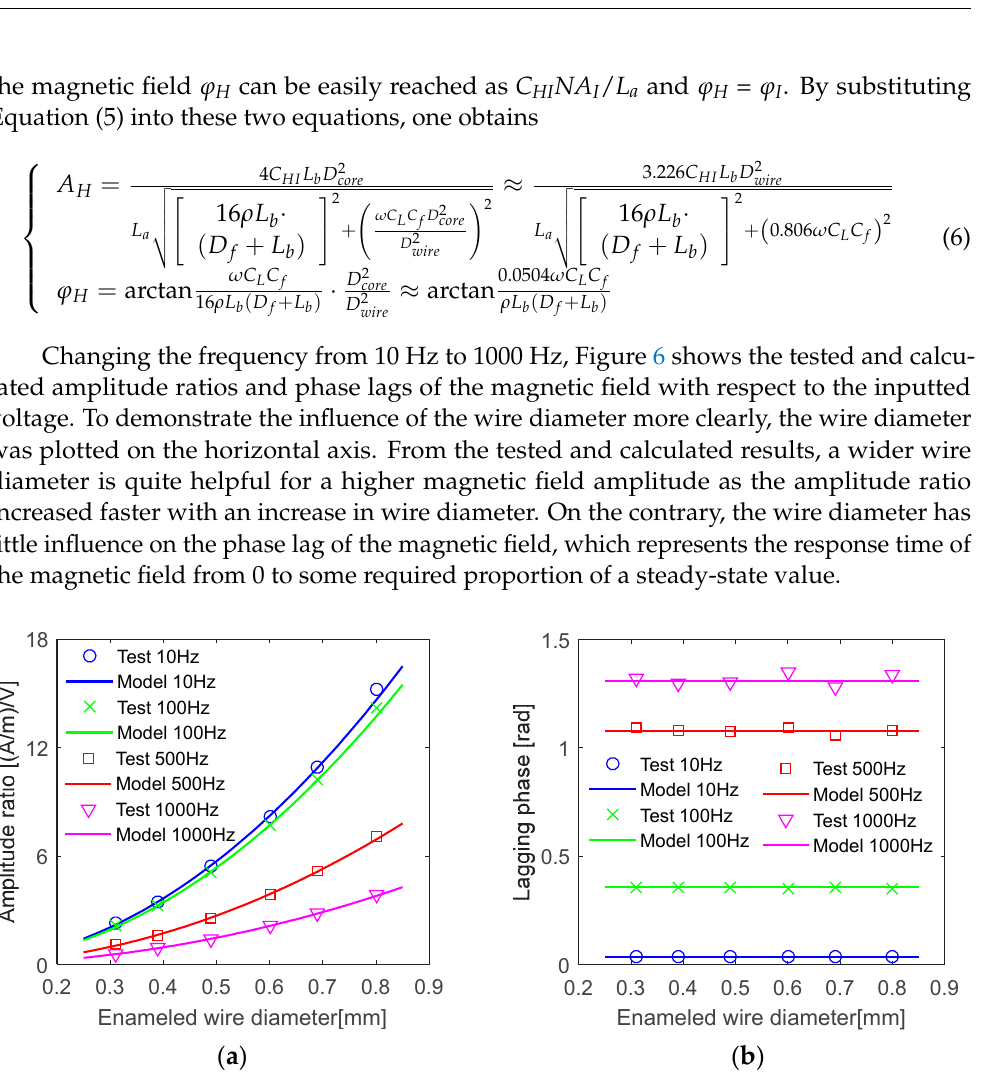
Figure 7. The relative errors of the model in computing the coil current under a harmonic voltage: ( a ) the relative errors of computing the amplitude ratio; ( b ) the relative errors of computing the phase lag.